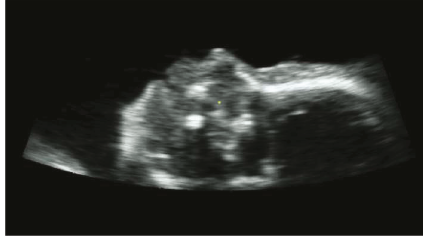
Figure 2: 2D image or